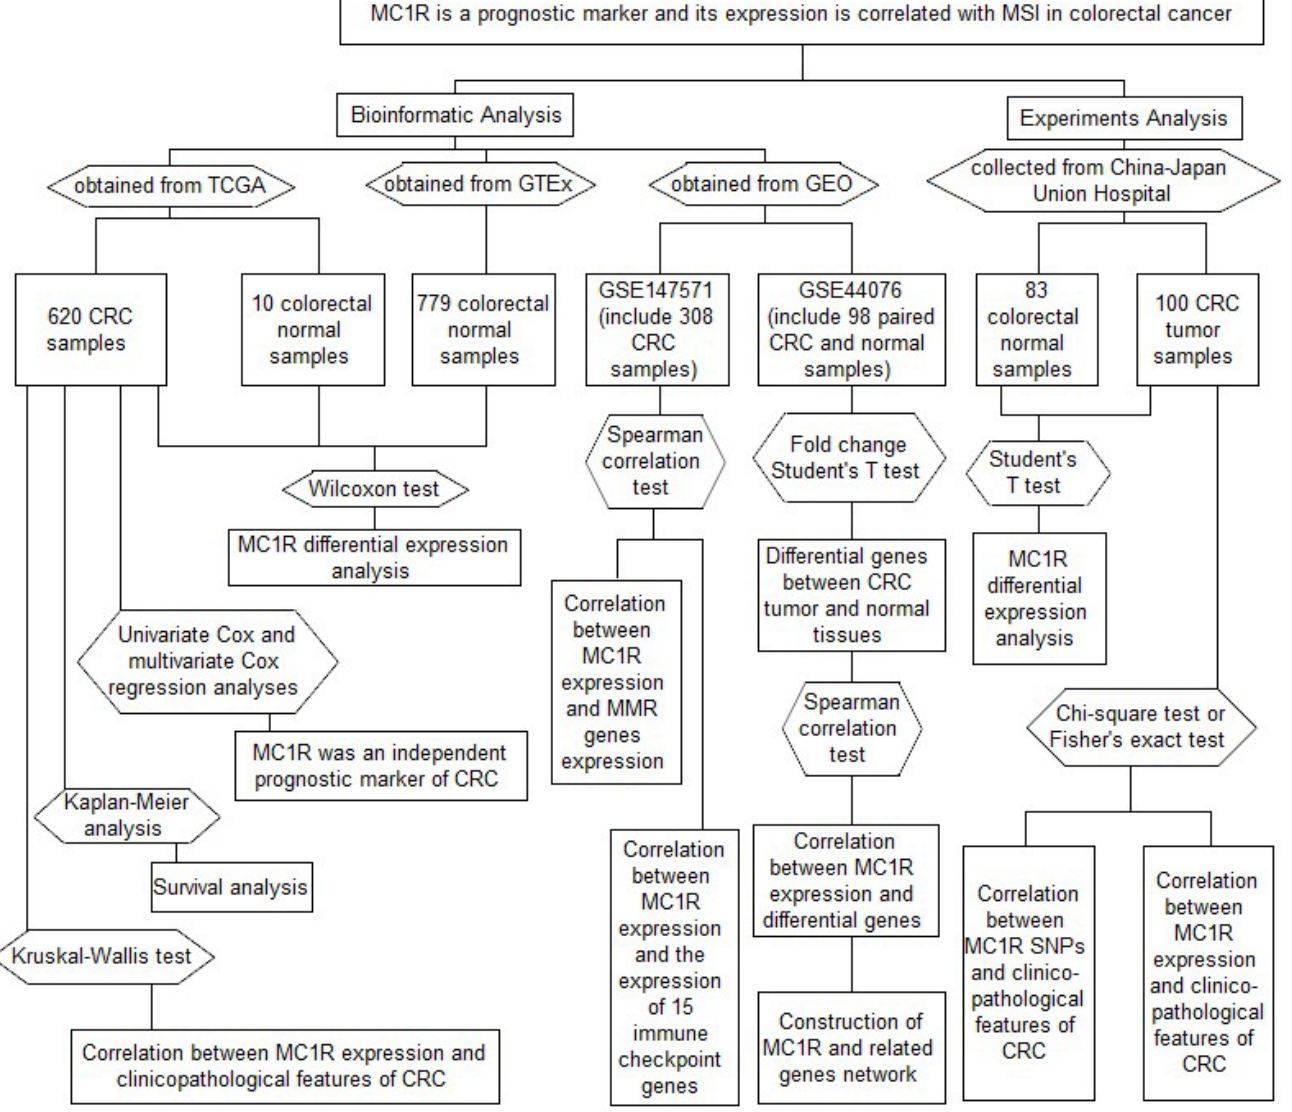
Figure 1. Illustration of study workflow. The flowchart of data collection and method implementation in this work.